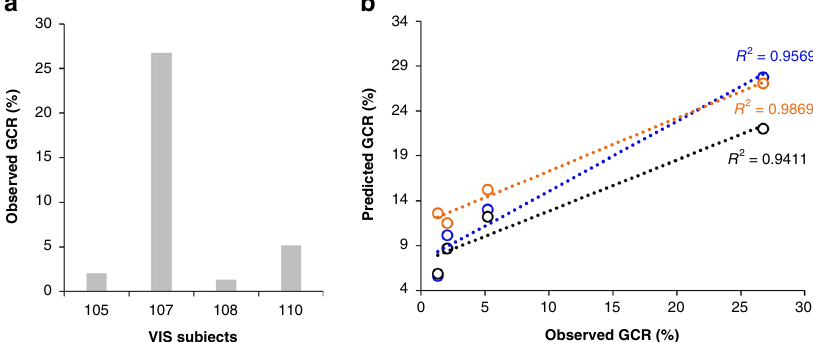
Fig. 6 Human malaria VIS subjects ’ observed and predicted GCRs correlate. Ring-stage parasite and newly released, mature gametocyte levels in four biologically independent Volunteer Infection Study (VIS) subjects ( n = 4, 105, 107, 108, and 110) were quanti fi ed on day (D)7 and 11 days later on D18, respectively, and used to determine the observed D7-gametocyte-conversion rate (GCR) ( a ). b Correlation between observed and predicted D7-GCRs in VIS subjects. The predicted D7 GCR was calculated for each subject based on their D7-gametocyte-committed (gc)-ring biomarker Δ Cts and the equation developed in Fig. 4d – f. Black, blue, and orange colors indicate the predicted GCRs for the n = four independent subjects using ap2-g, sur fi n 1.2, and sur fi n 13.1 , respectively. Source data are provided as a Source Data fi